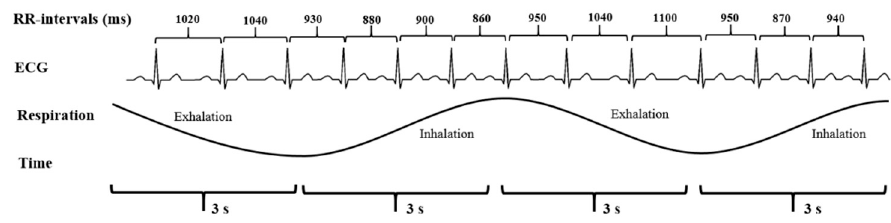
Figure 5. Electrocardiogram (ECG) exhibiting respiratory sinus arrhythmia.